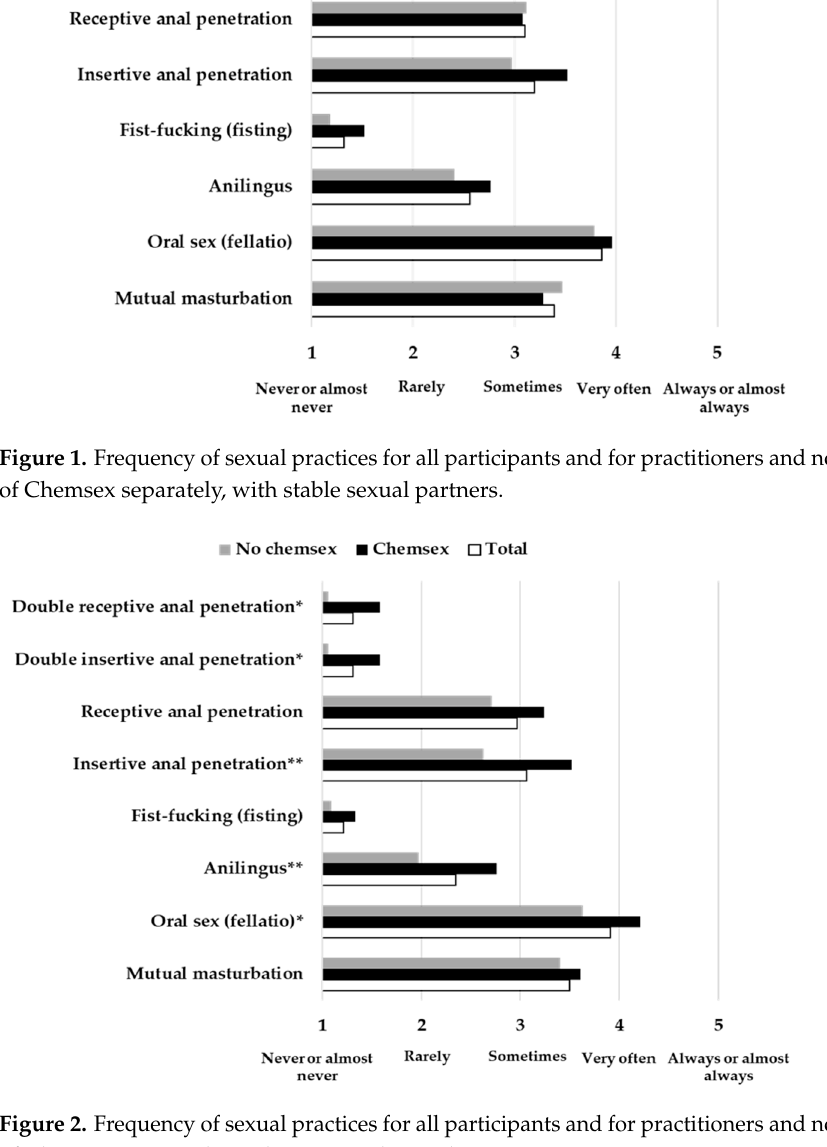
Figure 1. Frequency of sexual practices for all participants and for practitioners and non-practi- tioners of Chemsex separately, with stable sexual partners.